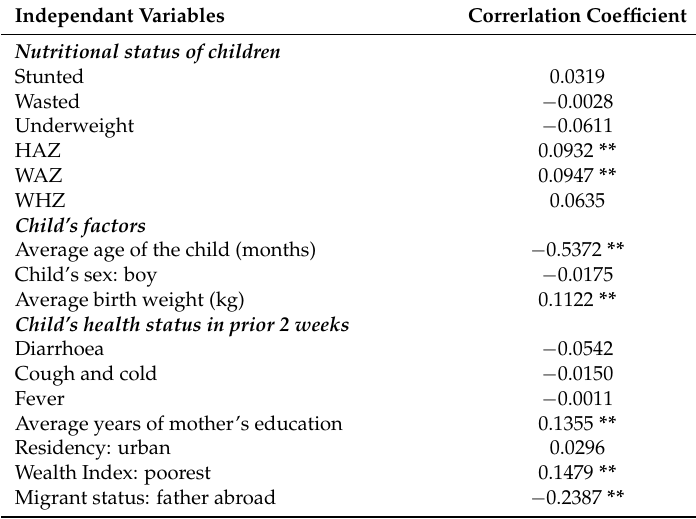
Table 3. Correlation of child and household variables (independent variables) with child care practices (dependent variable) ( n =